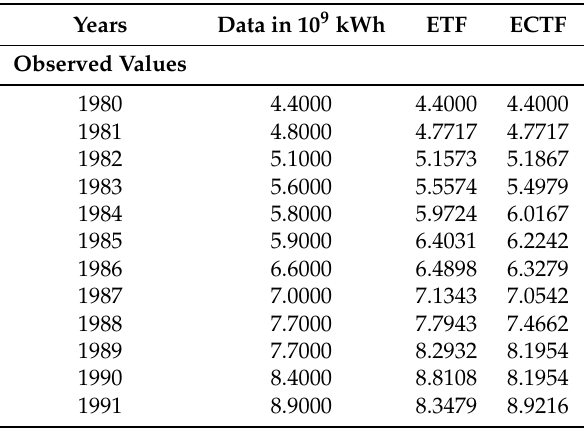
Figure 2. The data observed versus those fitted by the Estimated Conditional Trend Function (ECTF). Table 1. Fit from